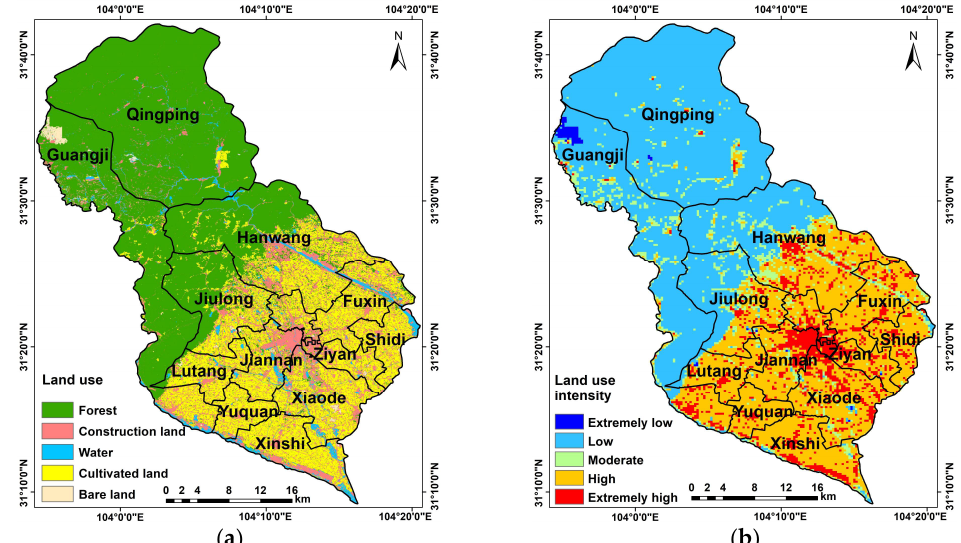
Figure 8. Land use information (( a ) land use classification; ( b ) land use